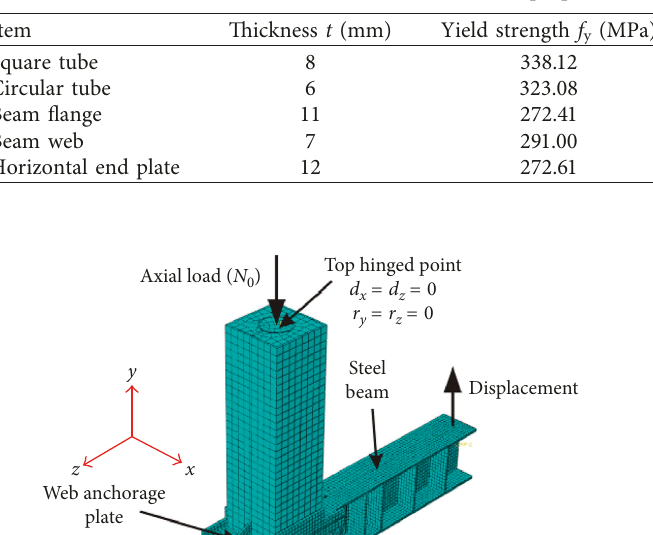
Table 2: Material properties of the steel